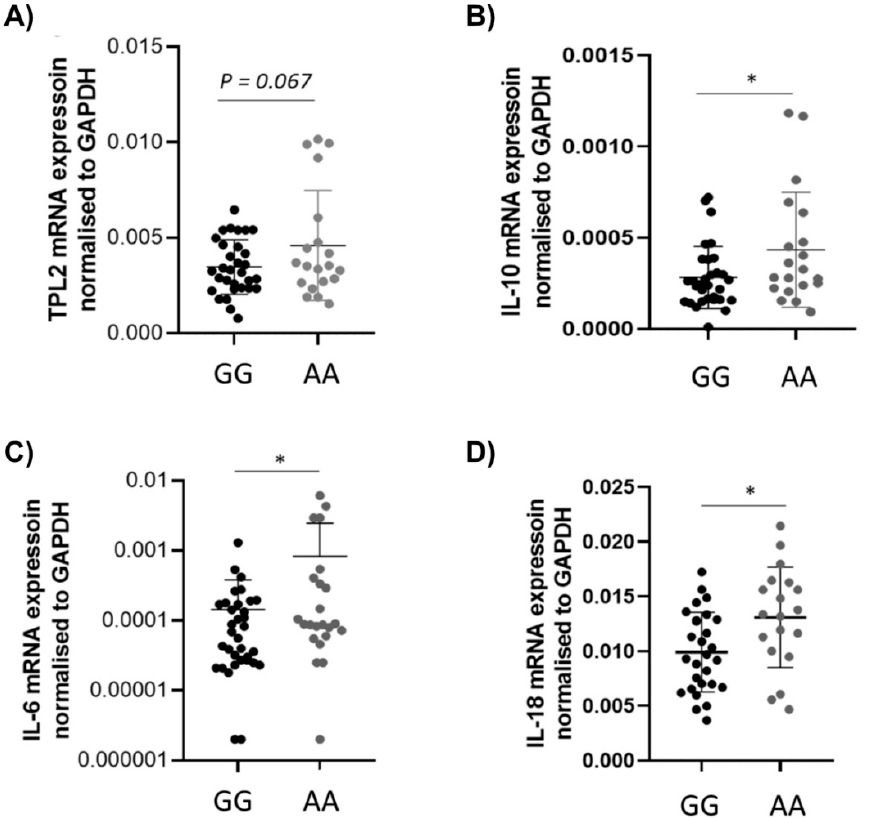
Figure 1. Cytokines IL-10 and IL-6, and IL-18 are decreased in patients with rs1042058 TPL2 variant in CD and UC, respectively. Intestinal biopsies from CD and UC patients with or without rs1042058 TPL2 variant were analyzed for mRNA expression of inflammatory cytokines. Graphs demonstrate mRNA levels of ( A ) TPL2 in CD patients stratified by the presence of the rs1042058 TPL2 variant, ( B ) IL-10 in DC patients, ( C ) IL-6 in CD patients, and ( D ) IL-18 mRNA expression in UC patients shows a significant decrease when carrying the rs1042058 TPL2 variant. Error bars represent means ± SD. * = p < 0.05.